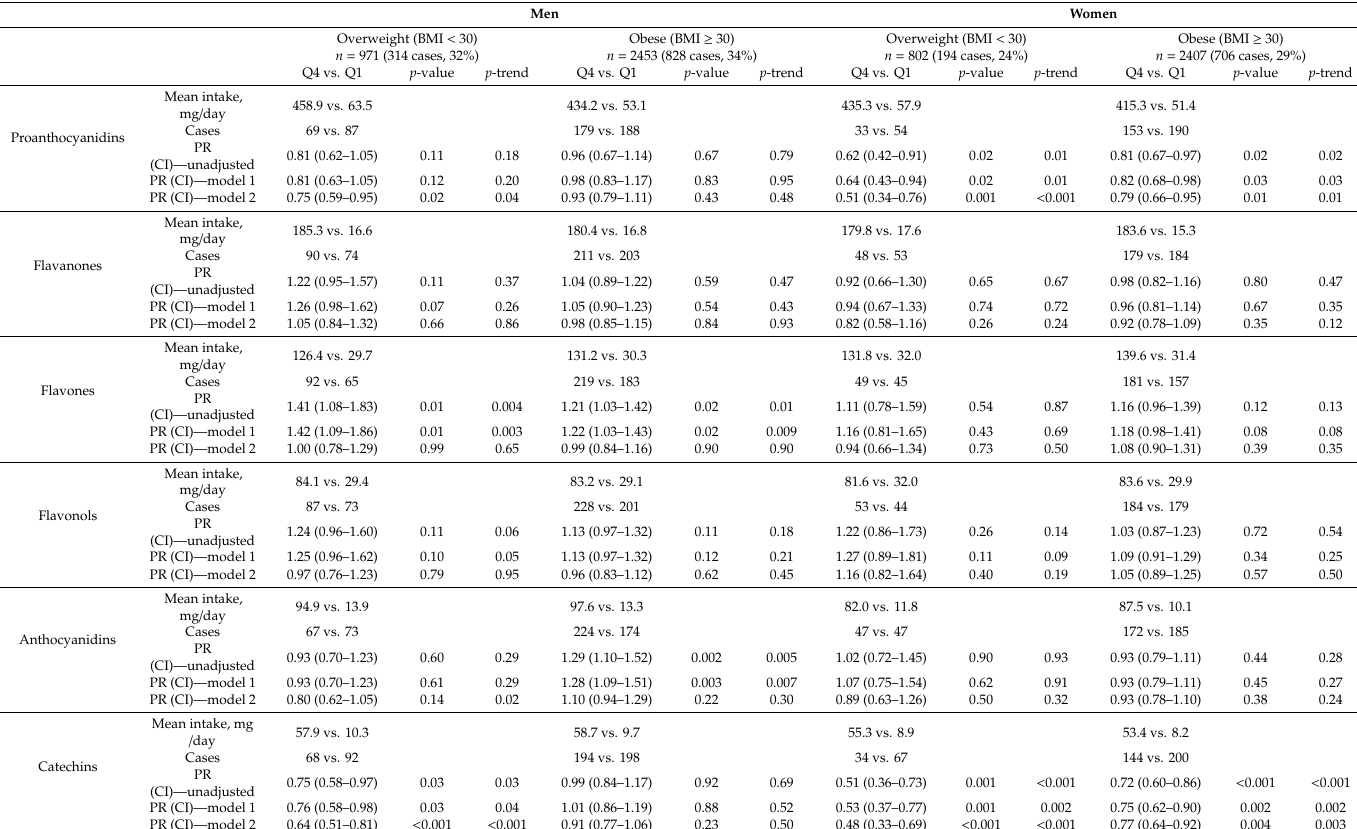
Table 3. Prevalence ratio (PR) and confidence interval (CI) for prevalence of T2D and groups of energy-adjusted polyphenol intake by sex and